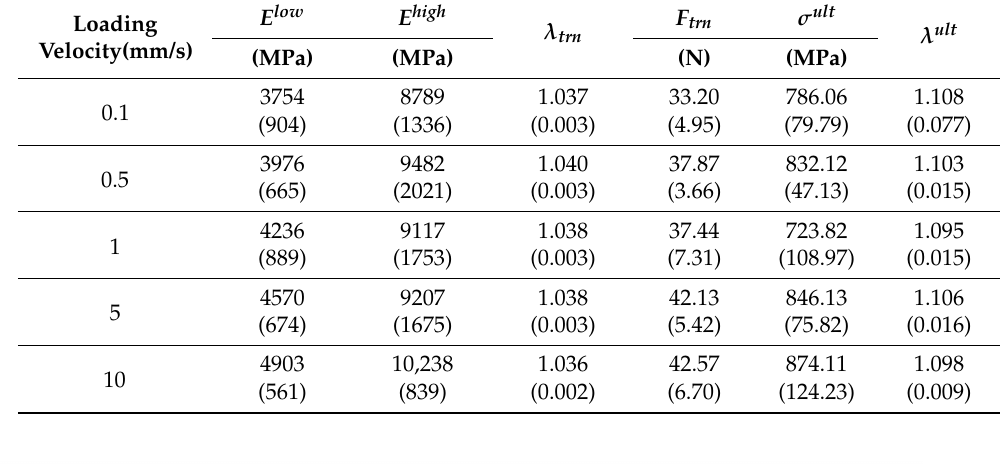
Table 2. Results of the load-to-failure test fitted by the bilinear model for the 5 groups at different loading velocities. Values are given as the mean (SD).